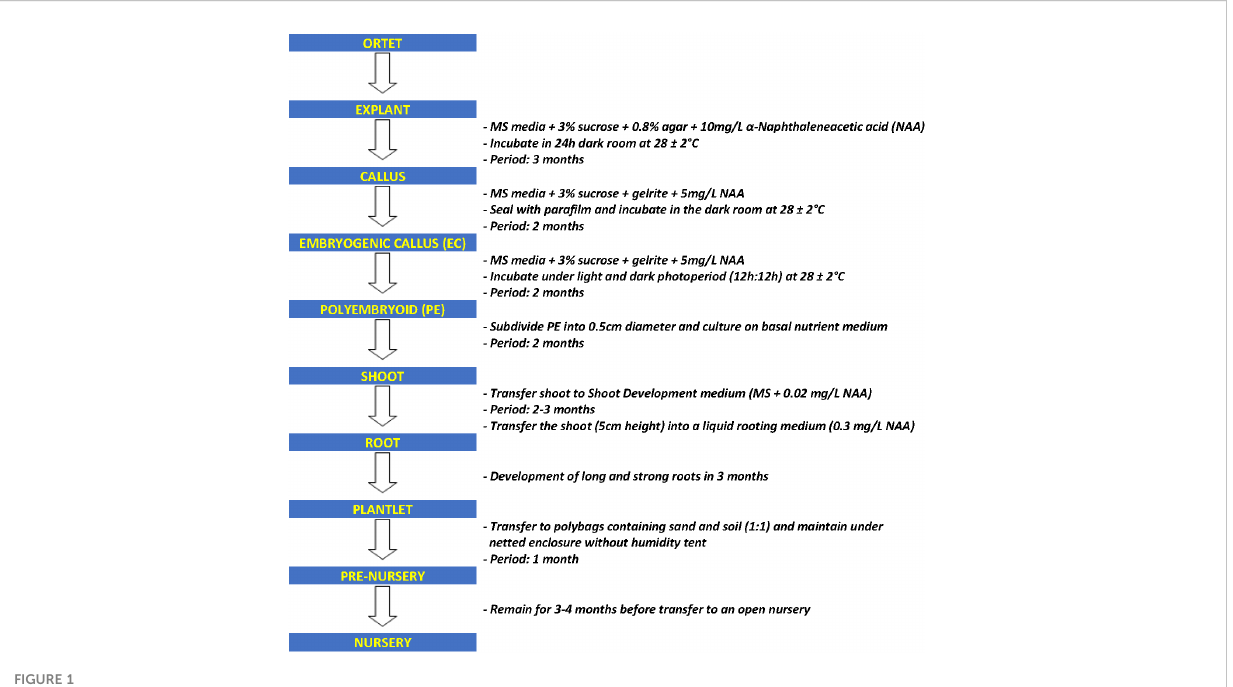
FIGURE 1 Flow chart of oil palm tissue culture